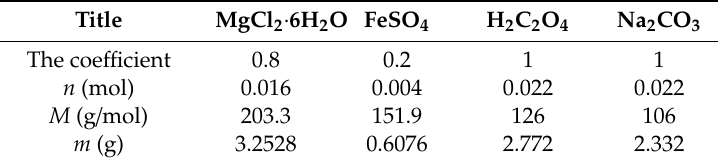
Table 1. Raw material proportion of oxalate coprecipitation method.